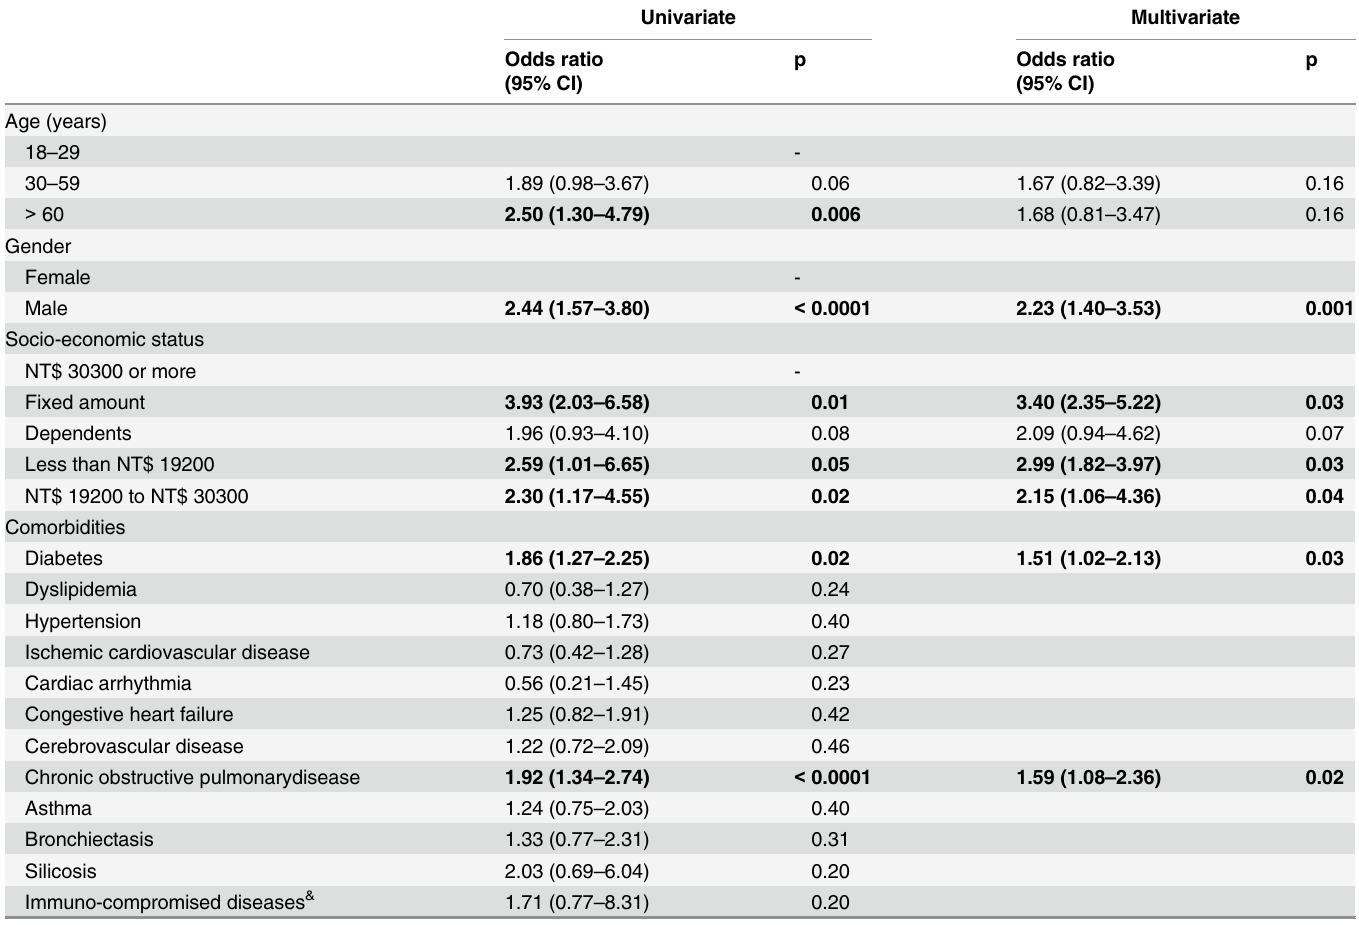
Table 4. Logistic regression analysis of predictors for tuberculosis